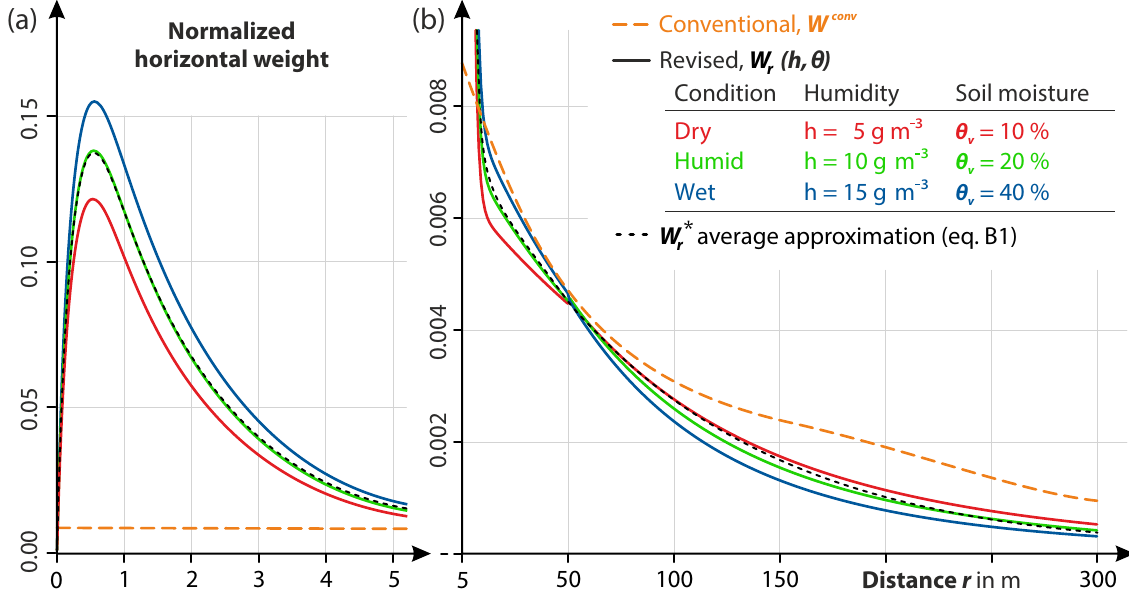
Figure 2. Comparison of normalized horizontal weighting functions (a) from 0 to 5m, and (b) from 5 to 300m. Graphs show the conventional (almost exponential) approach W conv r (Eq. 5), the revised curves W r (h , θ ) for three wetness conditions (Eq. 6), and an approximation W ∗ r based on a simplified equation (Appendix B). The conventional approach is insensitive to air and soil water content and highly underestimates the contribution of nearby areas r < 10m when compared to the revised